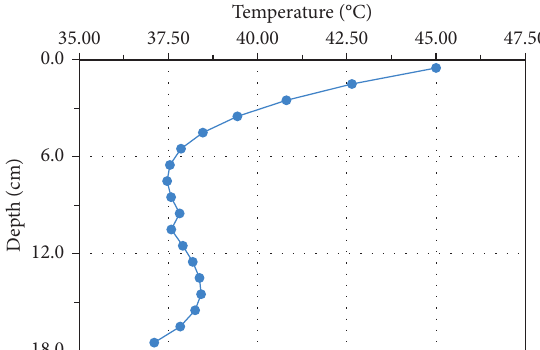
Figure 4: Equivalent rutting temperature.